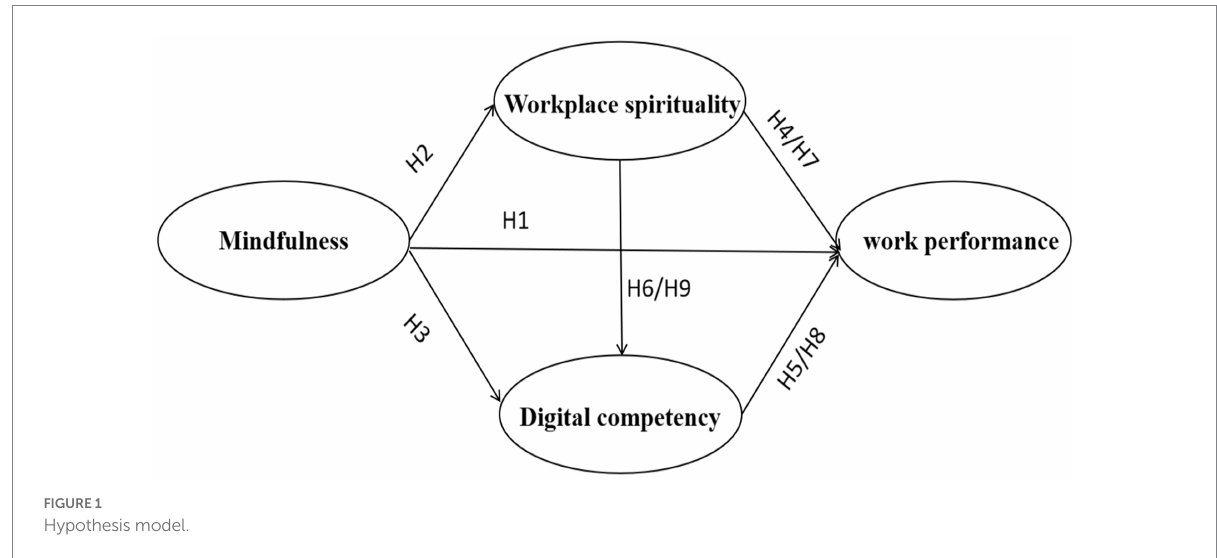
FIGURE 1 Hypothesis